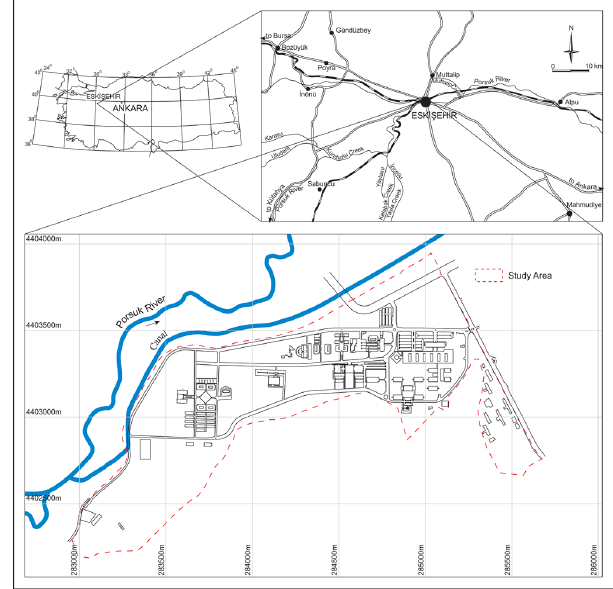
Fig. 1. Location map of the study